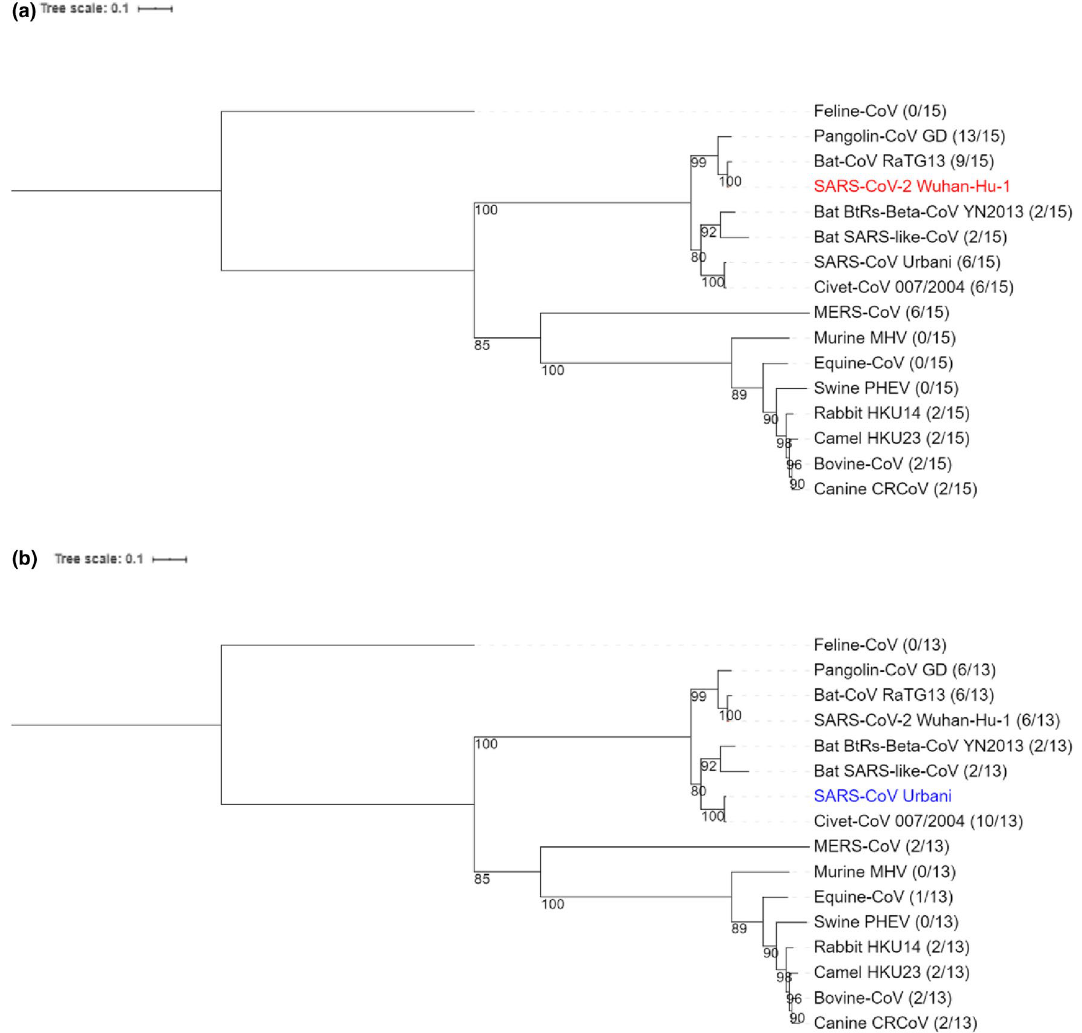
Figure 4. Phylogenetic reconstruction of 16 MAFFT G-INS-i aligned coronavirus S protein-coding genes. Infected mammalian species belong to the Artiodactyla, Canivora, Chiroptera, Lagomorpha, Perissodactyla, Primates, Pholidota and Rodentia orders. The phylogenetic tree is constructed using the maximum-likelihood- based PHYML approach, with best model = WAG + G + I + F, and Bootstrap = 100. Pangolin-CoV GX strain was excluded in favor of Pangolin-CoV GD strain having better sequence coverage. The ratio appended to each coronavirus indicates the total number of amino acid matches when coronavirus S protein gene was compared to ( a ) SARS-CoV-2 S protein gene (in red) at its 15 key ACE2-binding sites and to ( b ) SARS-CoV S protein gene (in blue) at its 13 key ACE-2 binding